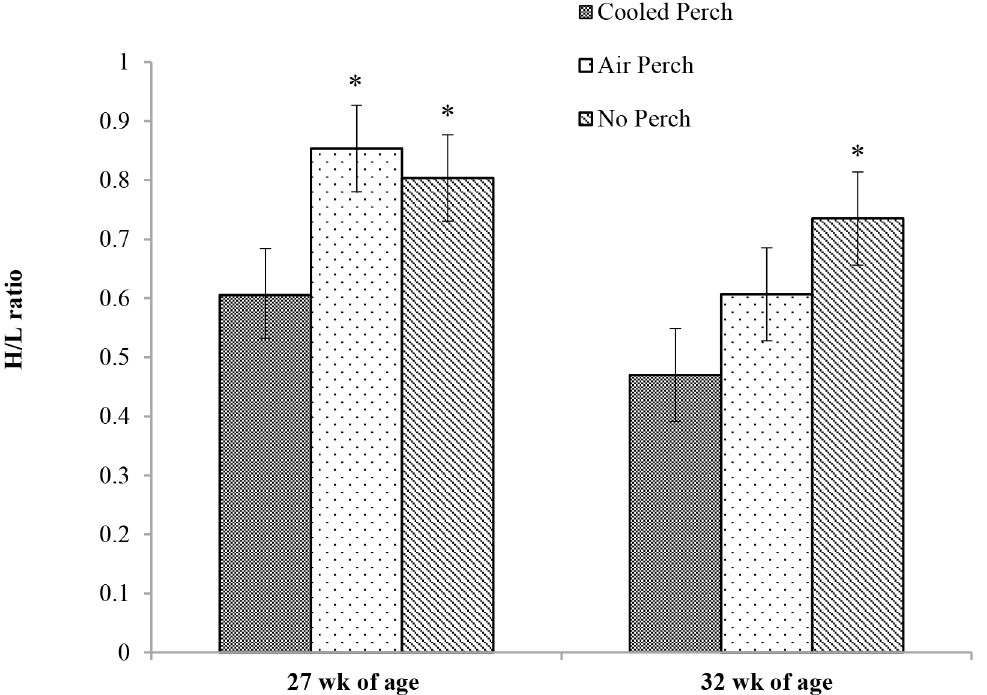
Fig 2. The effect of thermally cooled perches on heterophil/lymphocyte ratios. The heterophil to lymphocyte (H/L) ratios of hens subjected to a heating episode at 27.6 week of age and at the end of the study at 32 week of age. * Least square means were significant differences ( P < 0.05) within the same age